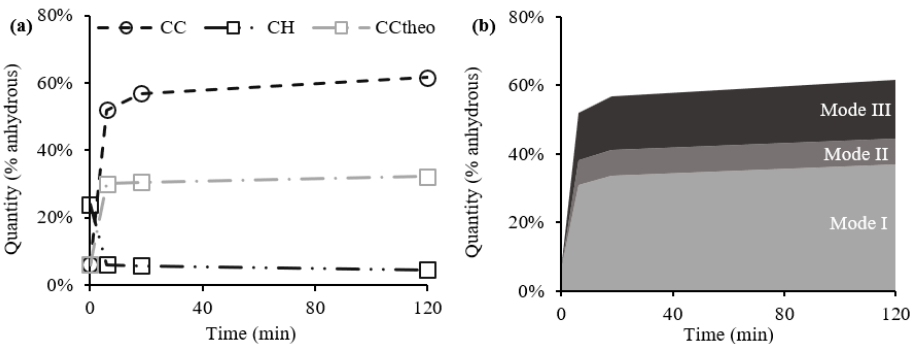
Figure 5. Results from CC (cid:3365) and CH ( a ) and modes of CC (cid:3365) ( b ).